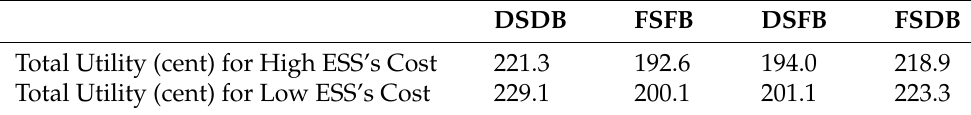
Figure 9. Total utility in the case in which the energy broker has low-cost ESS. Table 2. Total utility comparison under present and future ESS deployment